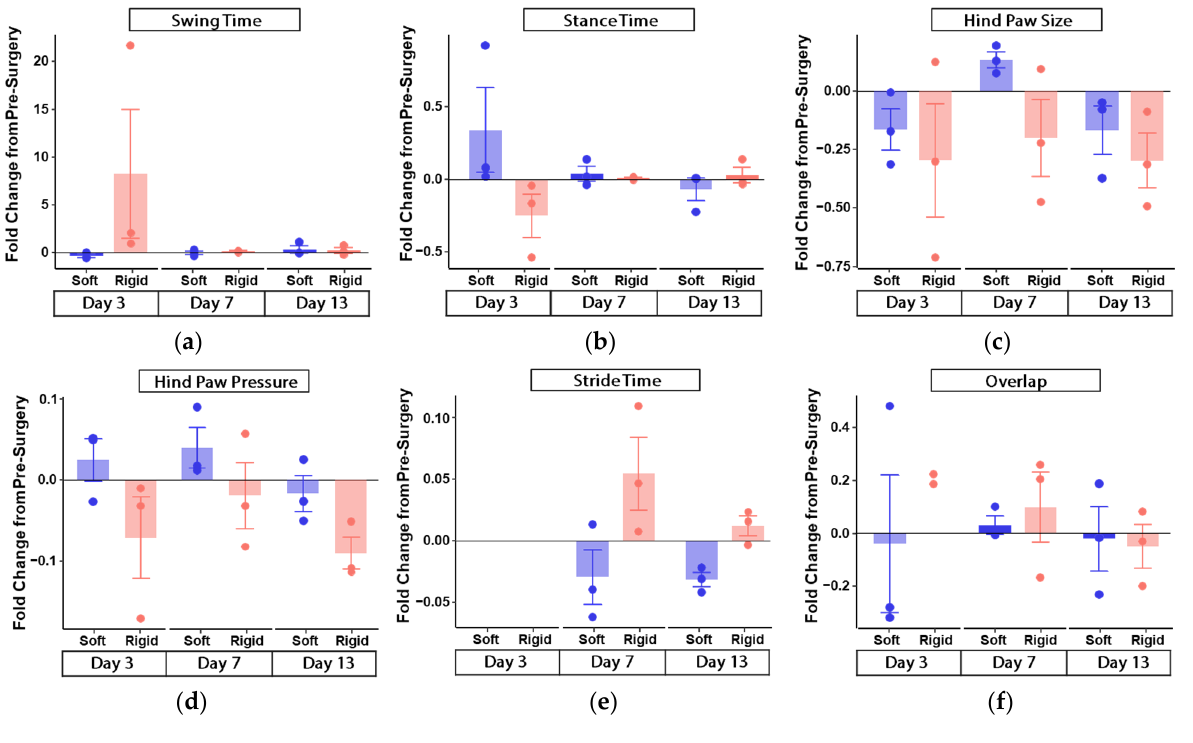
Figure 5. The results of gait analysis parameters across different time-points: ( a ) Swing time; ( b ) Stance time; ( c ) Hind paw size; ( d ) Hind paw pressure; ( e ) Stride time; and ( f ) Overlap.